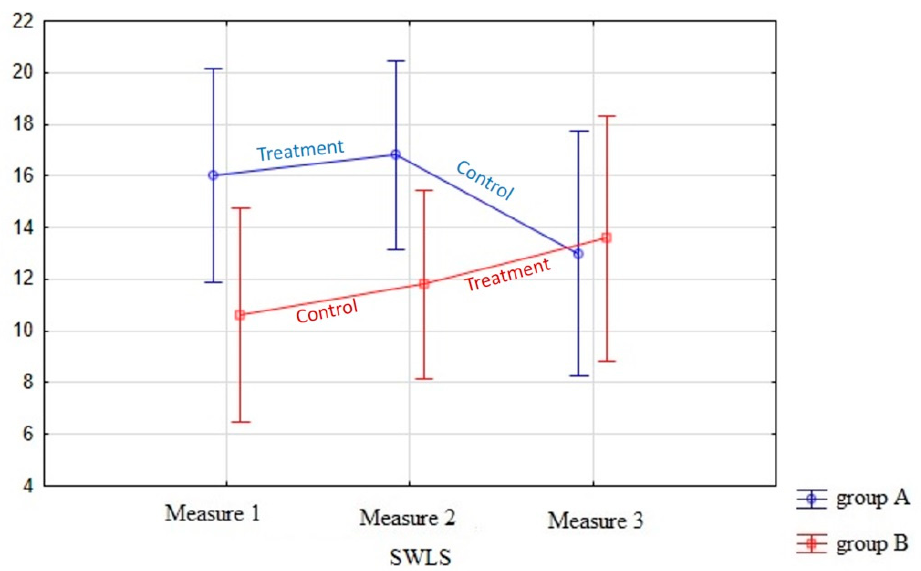
Figure 5. Graphical representation of SWLS test results.